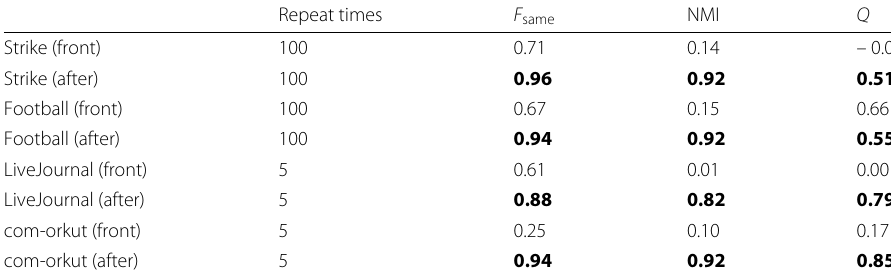
Table 4 The comparison of parametric experimental cluster results Repeat times F